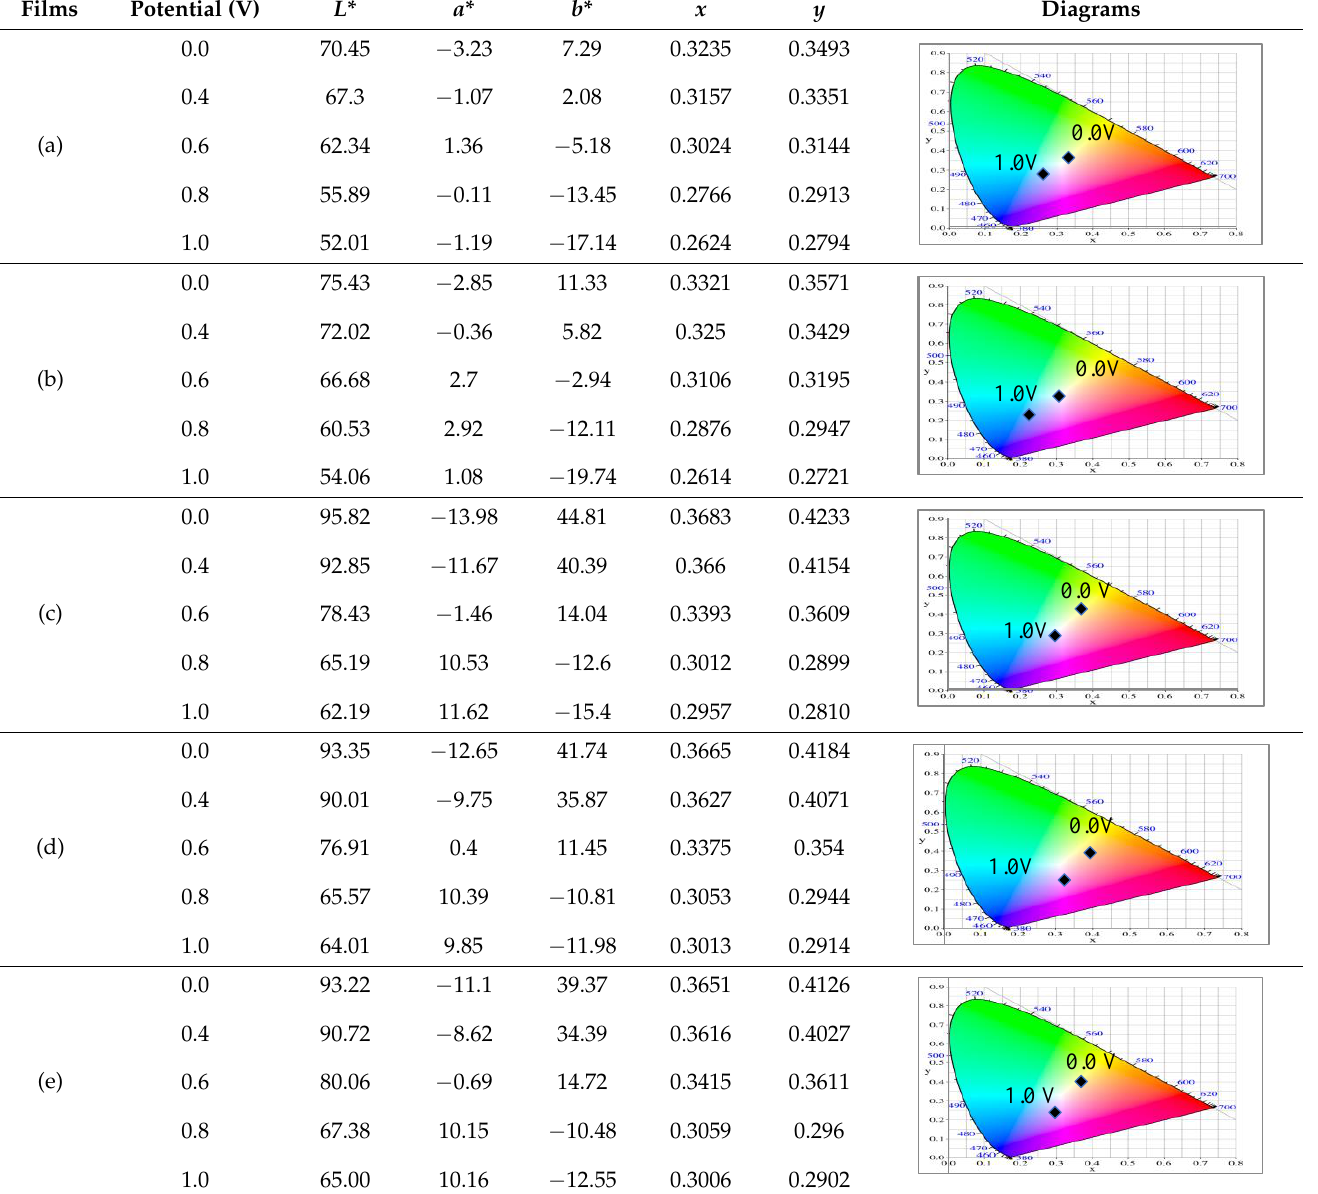
respectively. For 2-(2-thienyl)furan-based copolymers, P(DTC- co -TF) is mustard yellow , khaki , grey , and dark grey at 0.0, 0.4, 0.8, and 1.2 V, respectively, P(DTC- co -TF2) is dark yellow, yellowish-green, gunmetal gray, and dark gray at 0.0, 0.4, 0.8, and 1.2 V, respec- tively. The colorimetric values, CIE chromaticity values, and charts of PDTC, P(DTC- co -